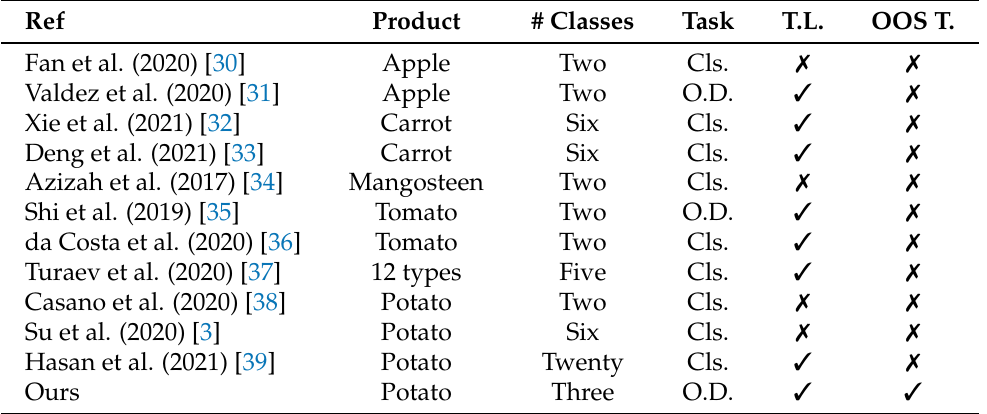
Table 1. Literature in DCNN-based surface defect detection for agricultural products.